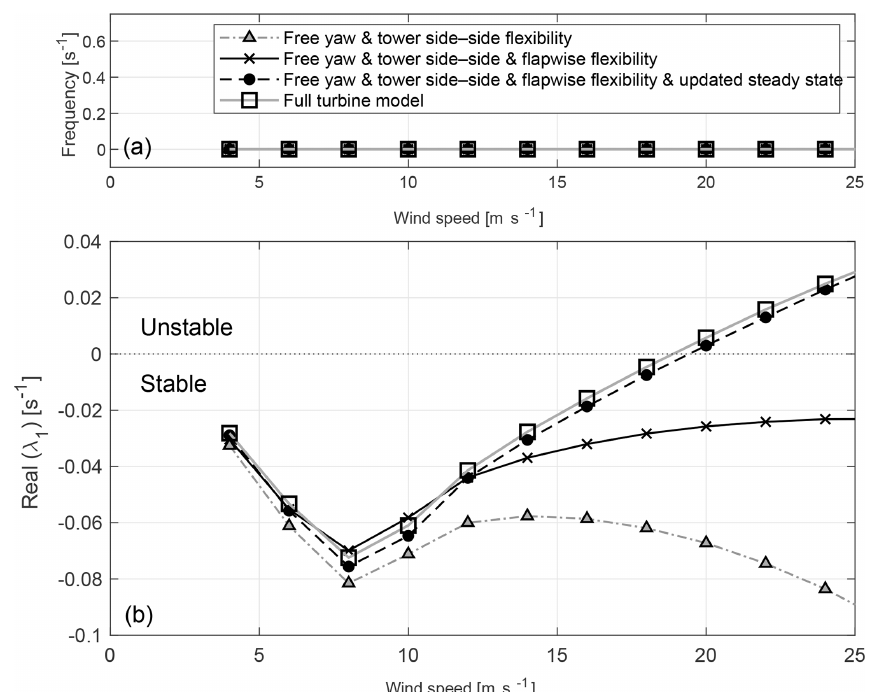
Figure 13. Comparison of the frequency (a) and real part of the first eigenvalue (b) of the yaw mode, for the imitation of the 2-DOF model, the model containing additionally the blade flapwise flexibility, the model with the additional blade flapwise flexibility and the linearization around the deformed steady state and the full turbine model with a linearization around the deformed steady state and updated operational data from